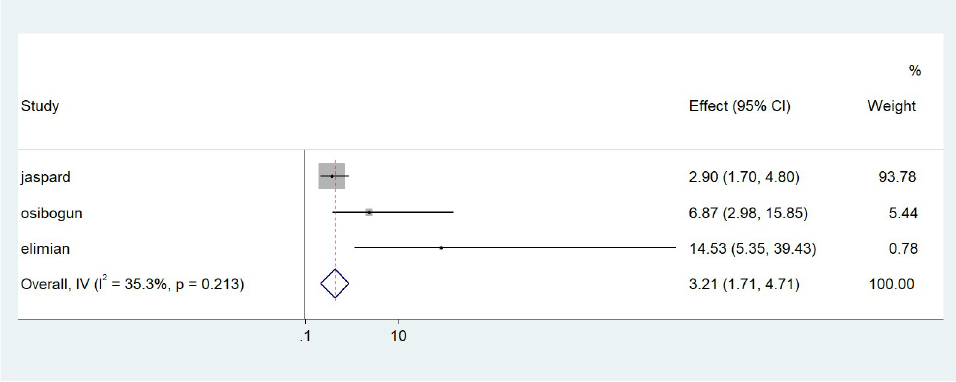
Fig 10. Forest plot showing the estimate for the effects of age ( � 60 vs < 60) on COVID-19 mortality.